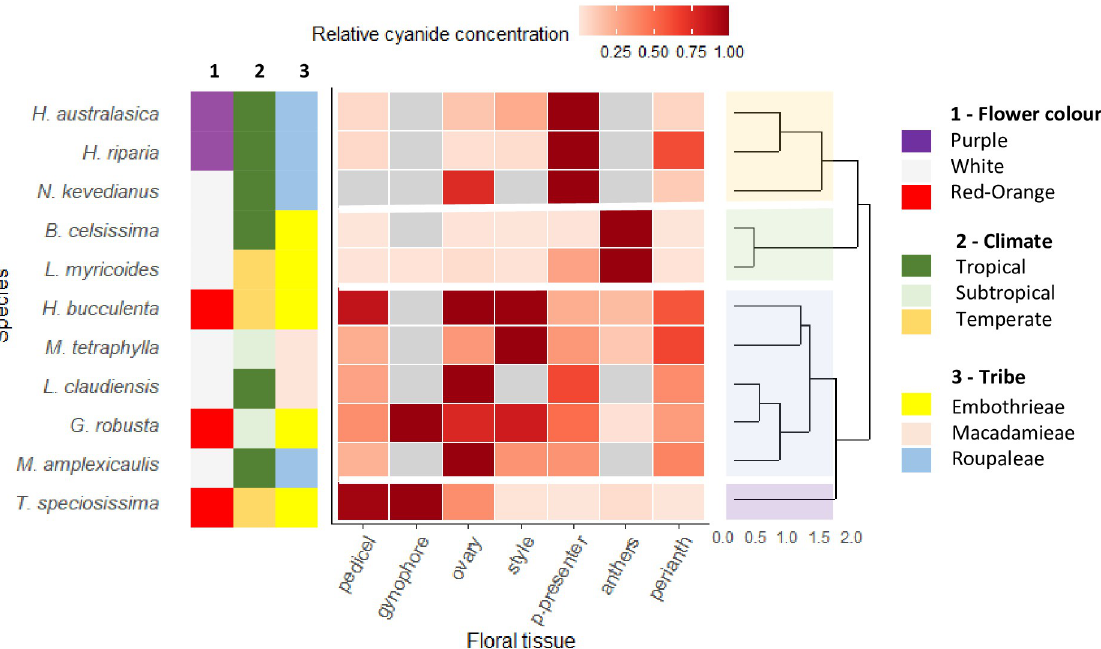
Fig 2. Hierarchical cluster analysis and heatmap of relative cyanide content in eleven Proteaceae species, with respect to three variables: Flower colour, climate (latitude) and tribe. For L . claudiensis and N . kevedianus “pollen presenter” the proportion of total evolved cyanide value represents the combined content of style and pollen presenter assayed together. Anthers were analysed with perianth for H . australasica , H . riparia , N . kevedianus , L . claudiensis and M . amplexicaulis . Gynophores were only present in L . myricoides , T . speciosissima and G . robusta florets. N . kevedianus florets do not have pedicels. Grey squares indicate no value. Four major groups of CNglyc allocation patterns within flowers were identified indicated by different colour shading in the